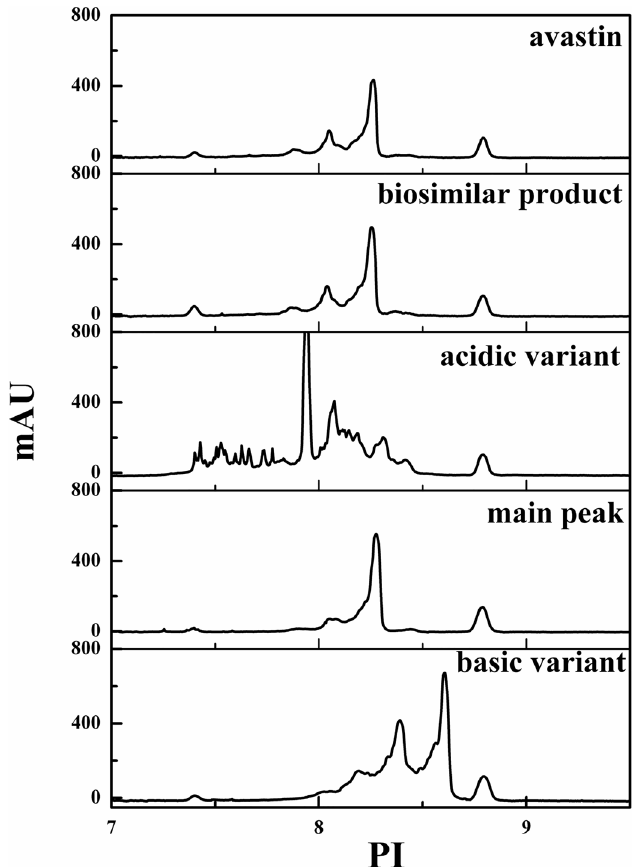
Fig 3. Imaged capillary isoelectric focusing for profile of the isolated charge variants, the biosimilar product and Avastin.